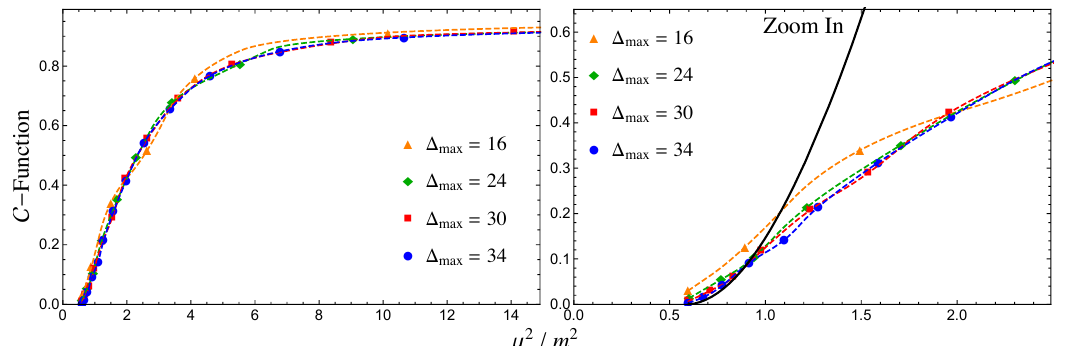
Figure 12 . Zamolodchikov C -function at di(cid:11)erent values of (cid:1) max . The (cid:1) max = 34 results (blue dots) are at (cid:22) (cid:21) = 1 : 96, and the couplings for the remaining results have been chosen such that the 4 (cid:25) mass gap remains (cid:12)xed. The points are the actual contributions of individual eigenstates to the spectral density, while the dashed lines are interpolations. The right plot is simply a zoomed-in version of the left one, and compares the conformal truncation results to the theoretical IR prediction for the Ising model (black curve), which includes the correction from the leading irrelevant operator (with (cid:3) = 1 : m